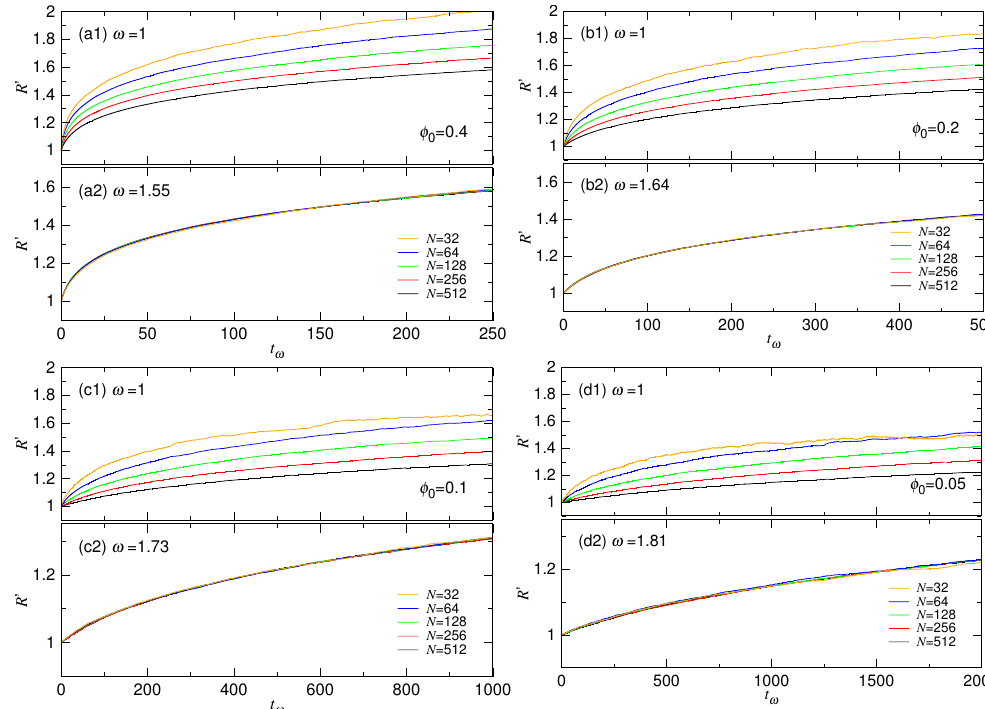
Figure 12. Scaled chain size R (cid:48) = R / R 0 vs. scaled time t ω = t × ω 9 − g N for the four studied φ 0 cases. The chain length N can be read from the legends in ( a2 – d2 ). Panels ( a1 – d1 ) are plotted by setting ω = 1. Under the setting, t ω is just t and, thus, the plots present the evolution of R (cid:48) against the ordinary time t . Panels ( a2 – d2 ) show the collapse of the time-scaled curves by using the appropriate ω value, 1.55, 1.64, 1.73, and 1.81,